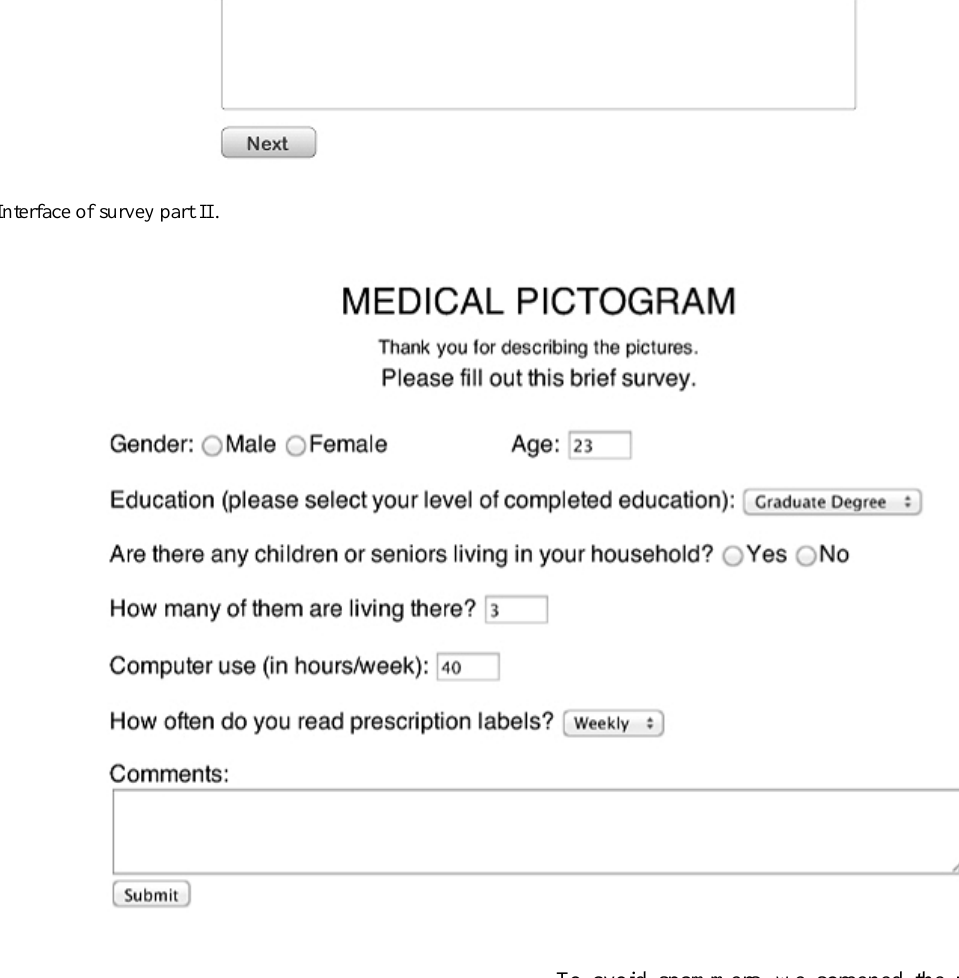
Figure 4. Interface of survey part